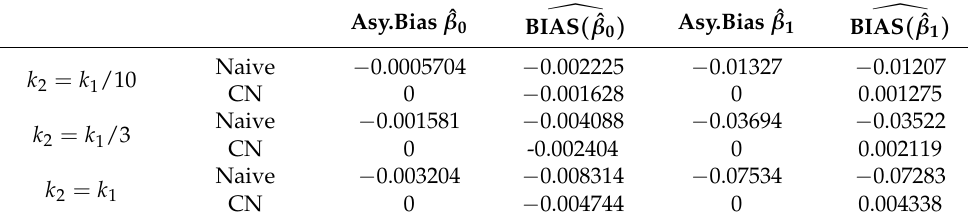
Table 10. Estimated bias and asymptotic bias in financial